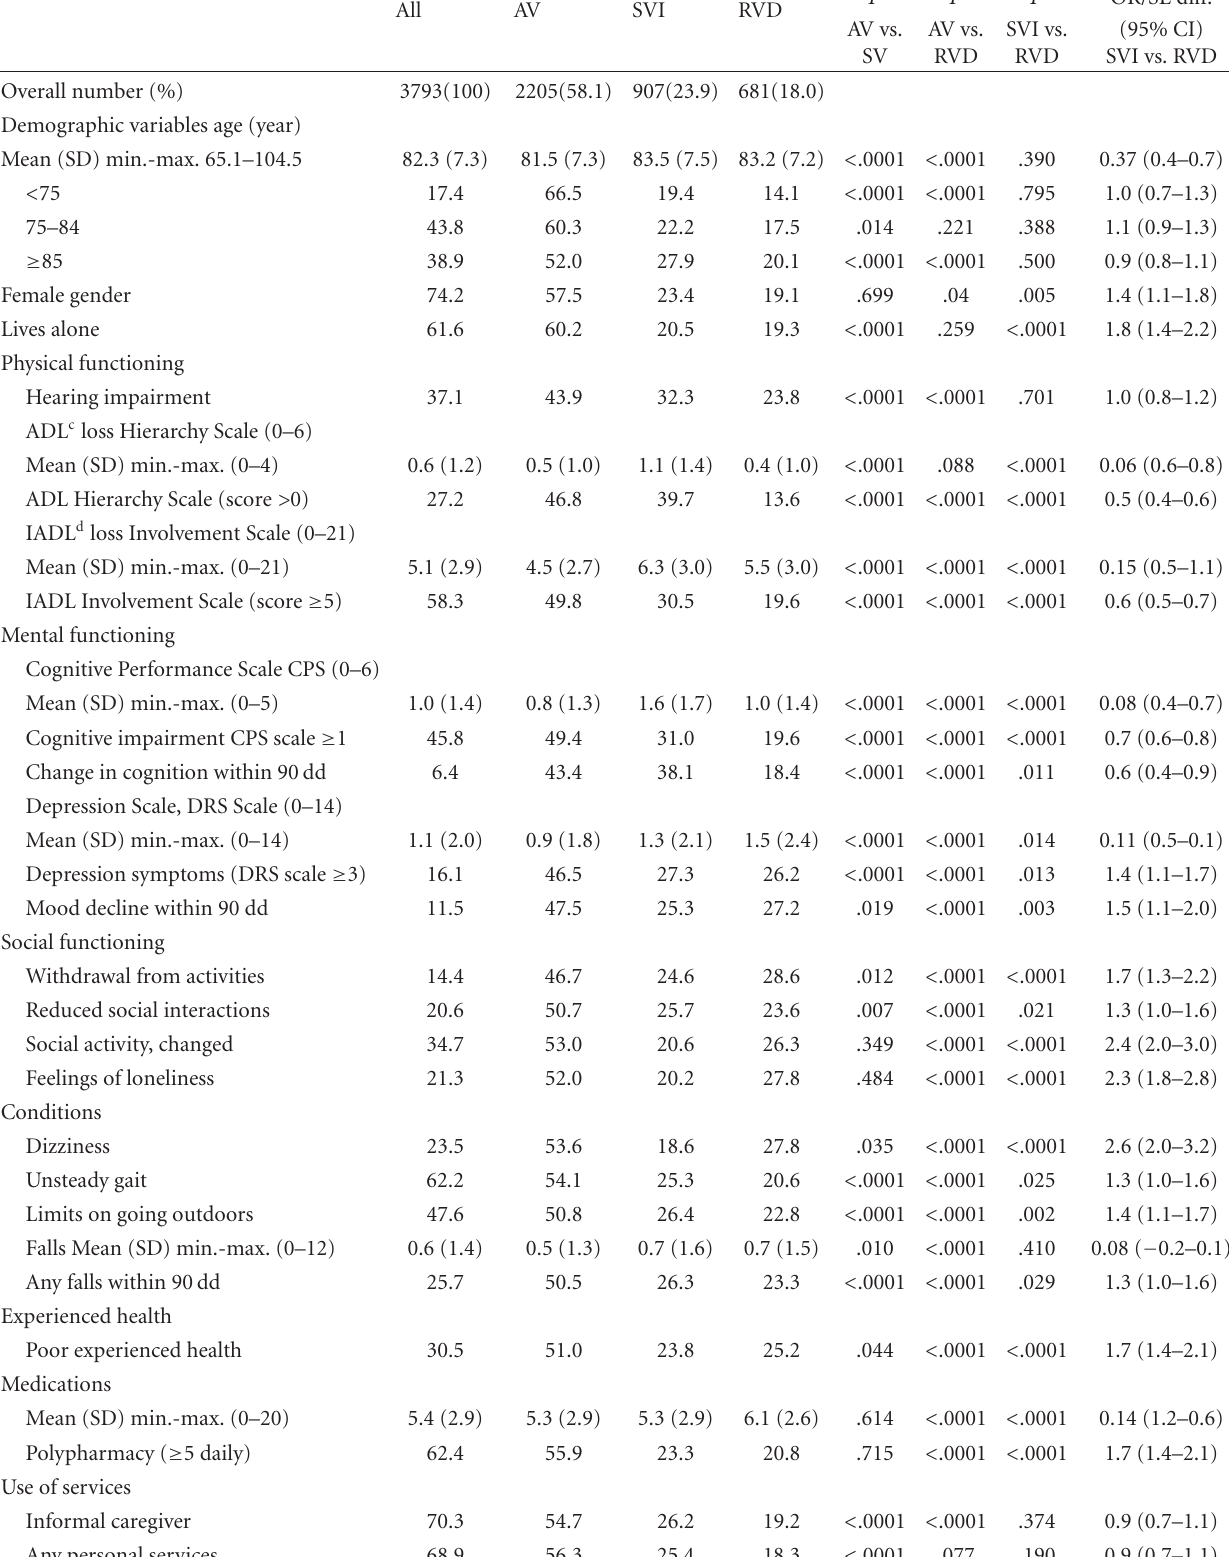
Table 2: Characteristics of patients in the AdHOC study in relation to self-reported vision; adequate vision (AV), stable visual impairment ( SVI ) a , and recent visual decline ( RVD ) b (percentage of cases unless otherwise stated). P values indicate di ff erences between the